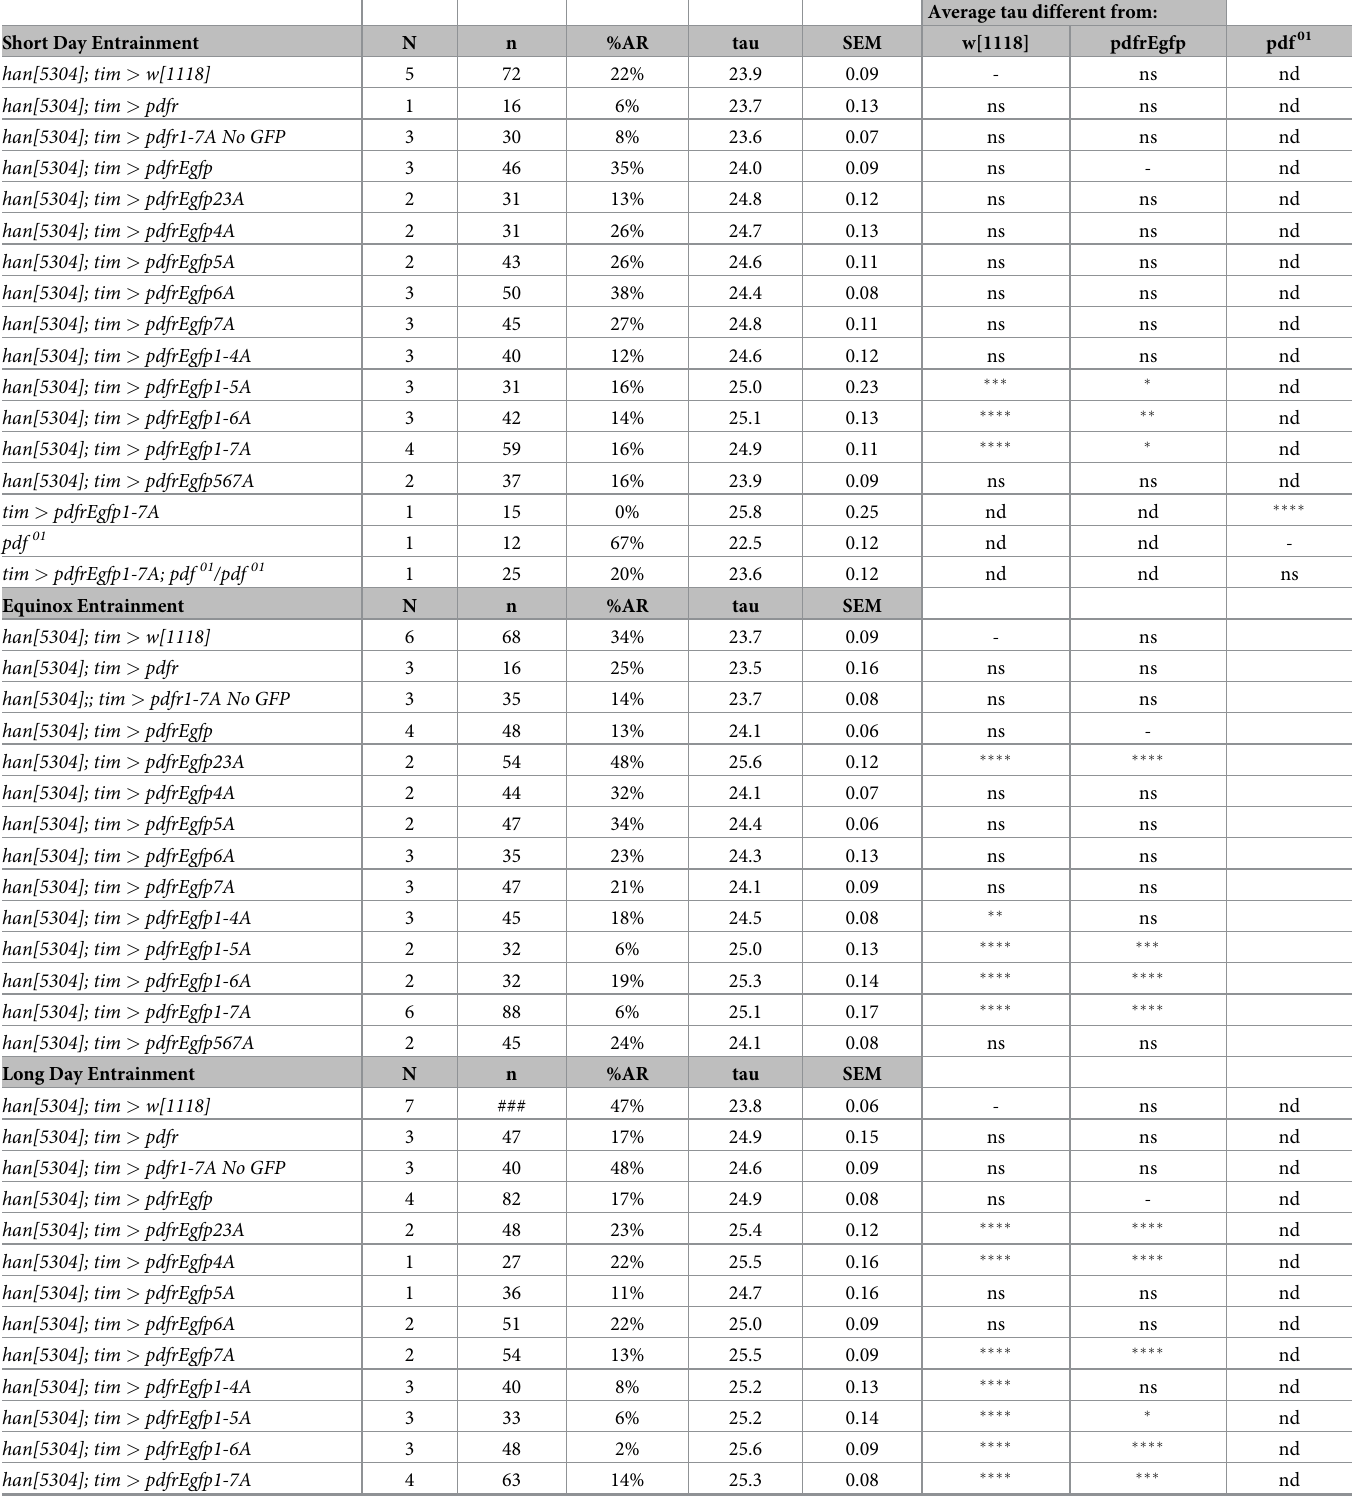
Average tau different from: